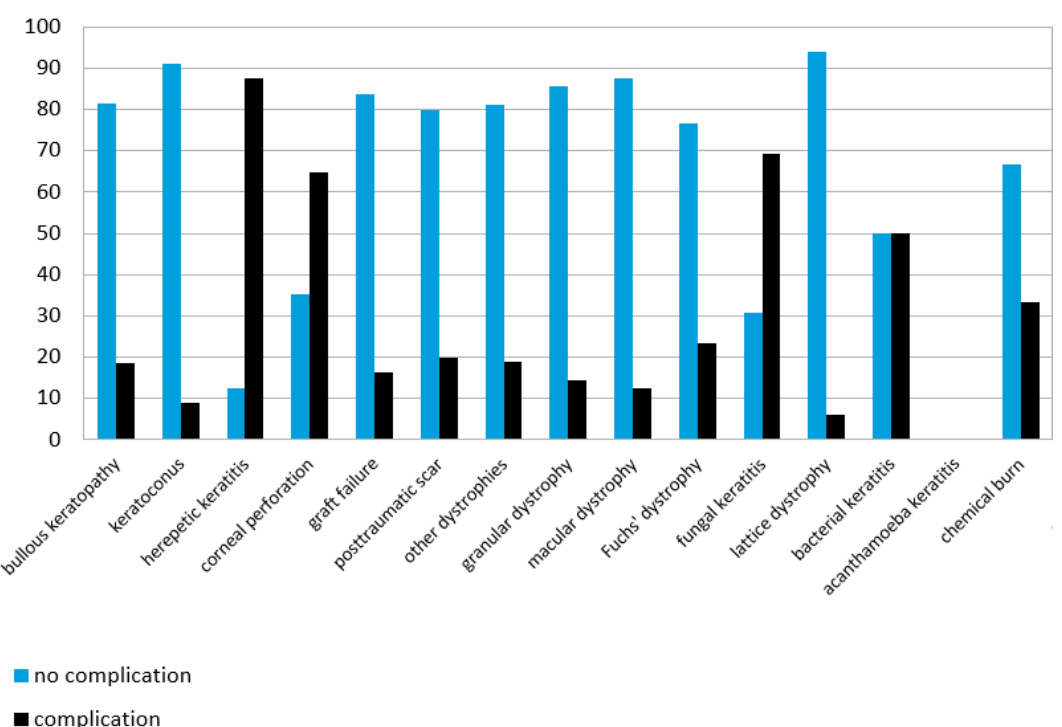
Figure 2. Success rate of penetrating keratoplasty depending on the indication.